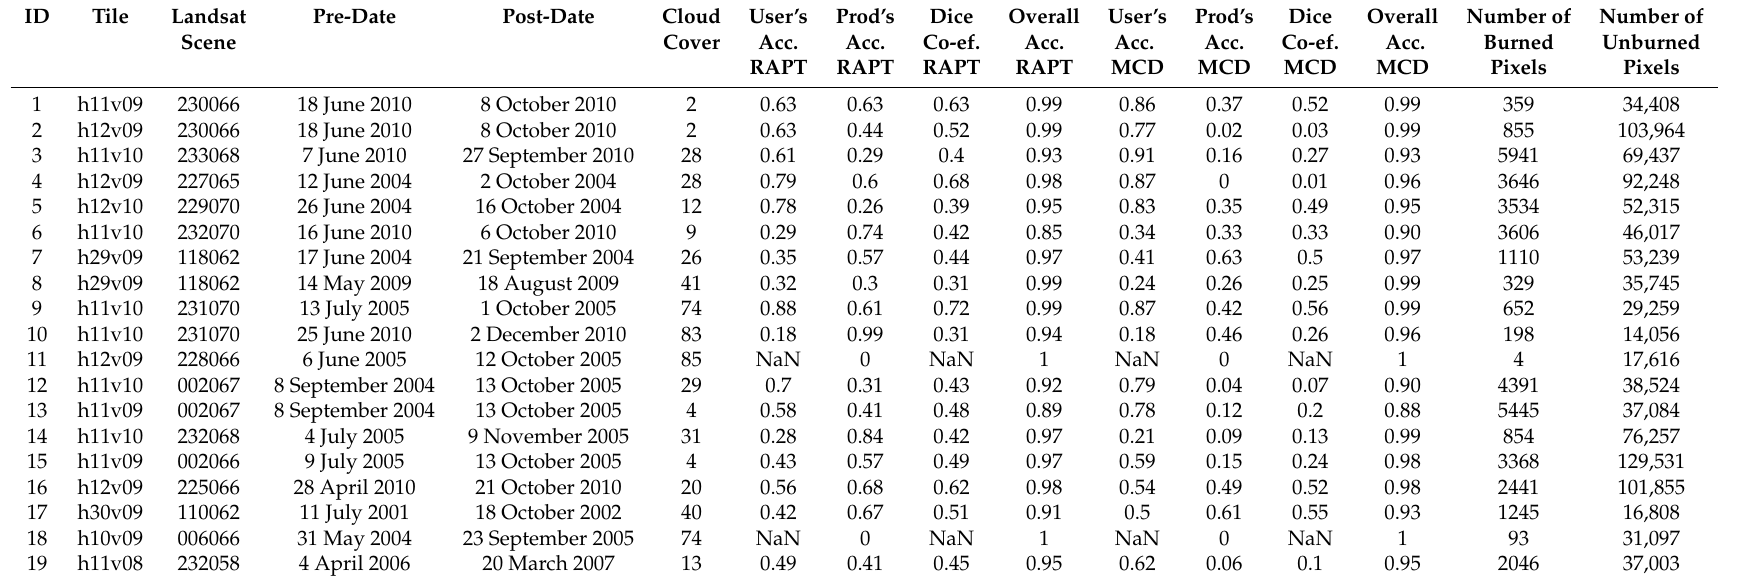
Table 1. Landsat validation results for 19 Landsat-based reference maps. The number of burned and unburned pixels are at 500 m MODIS